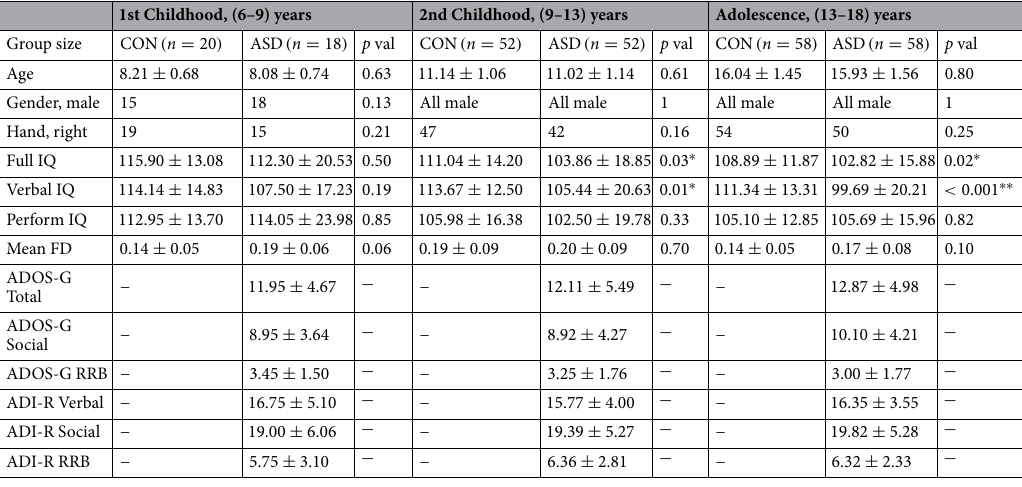
Table 3. Demographic data. p values are according to paired t-test for full/verbal/perform IQ, Mann-Whitney U test for age, mean FD and Chi-square test for gender and handedness. ** p < 0.01 , * p < 0.05 . Mean ± std, ADOS-G, the autism diagnostic observation schedule-generic; ADI-R, the autism diagnostic interview- revised; FD, frame-wise displacement; RRB, restricted and repetitive behaviors; CON, control; ASD, autism spectrum disorder.